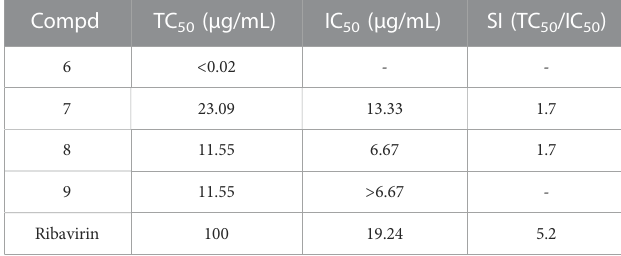
TABLE 3 Anti-coronavirus (HCoV-OC43) activity of compounds 7 – 9.